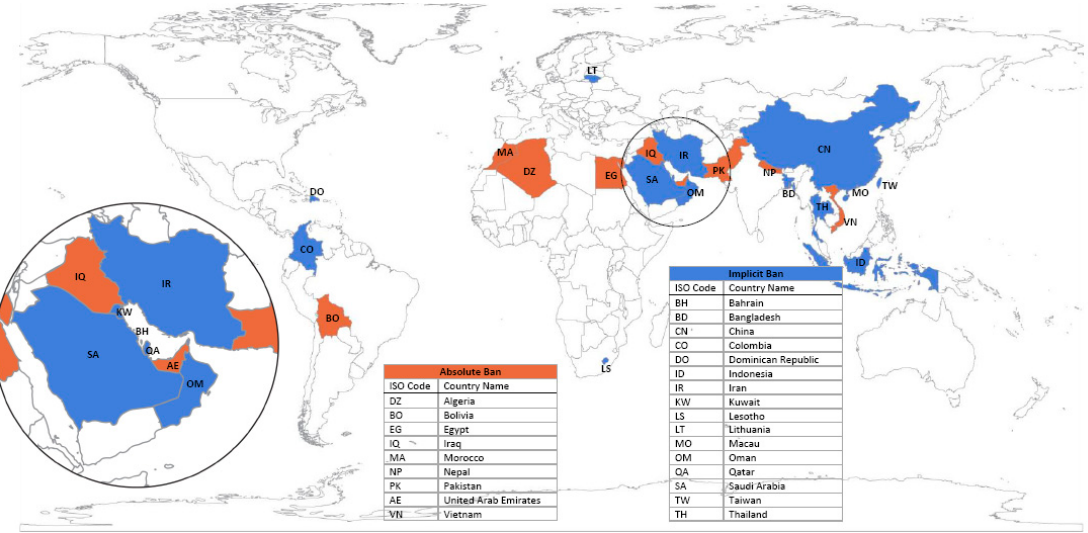
Figure 1. Legal status of cryptocurrencies. Source: Staff of Global Legal Research Directorate (2018).